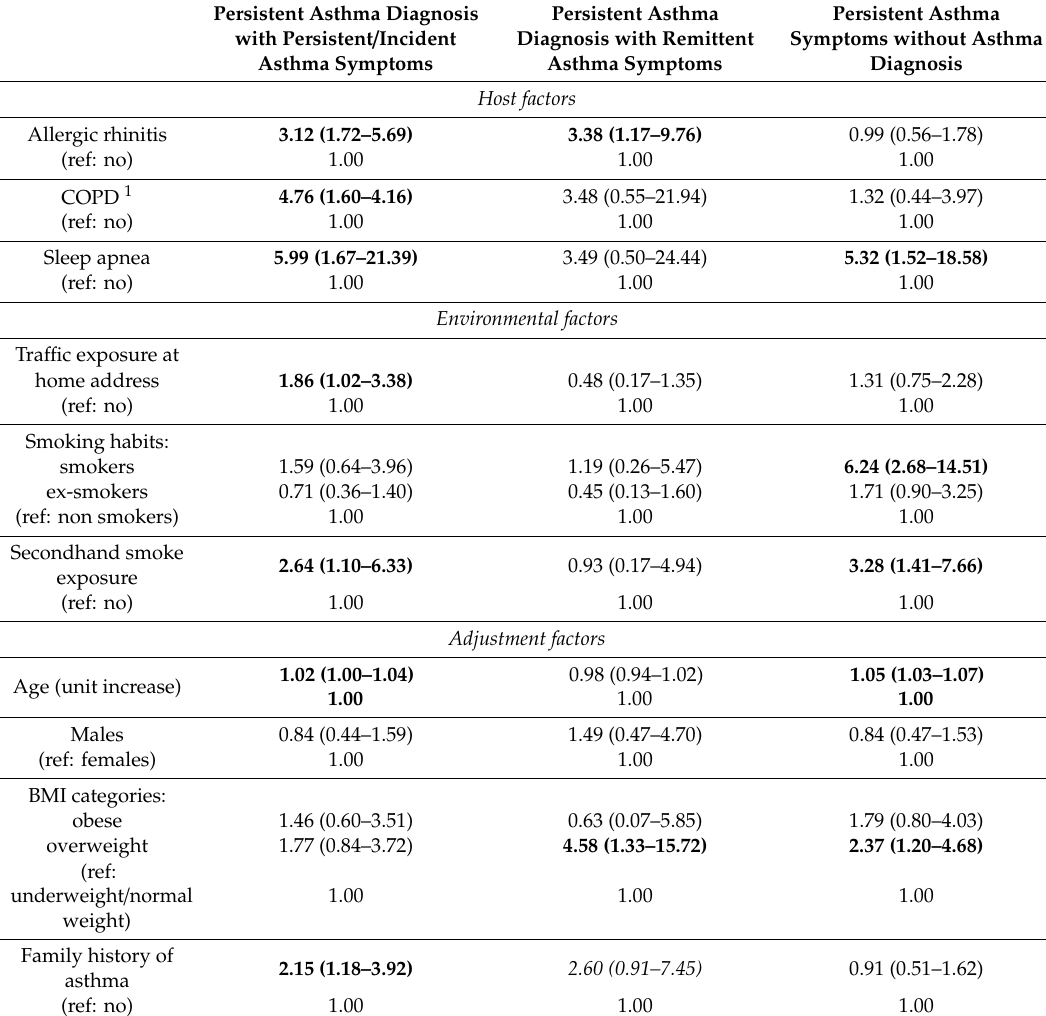
Table 7 describes the results of the multinomial logistic regression analysis for the associations among exposures to host and environmental risk factors and longitudinal asthma patterns (with “ex -asthma” as reference category). Table 7. Factors associated with longitudinal asthma patterns: Odds Ratio and 95% confidence